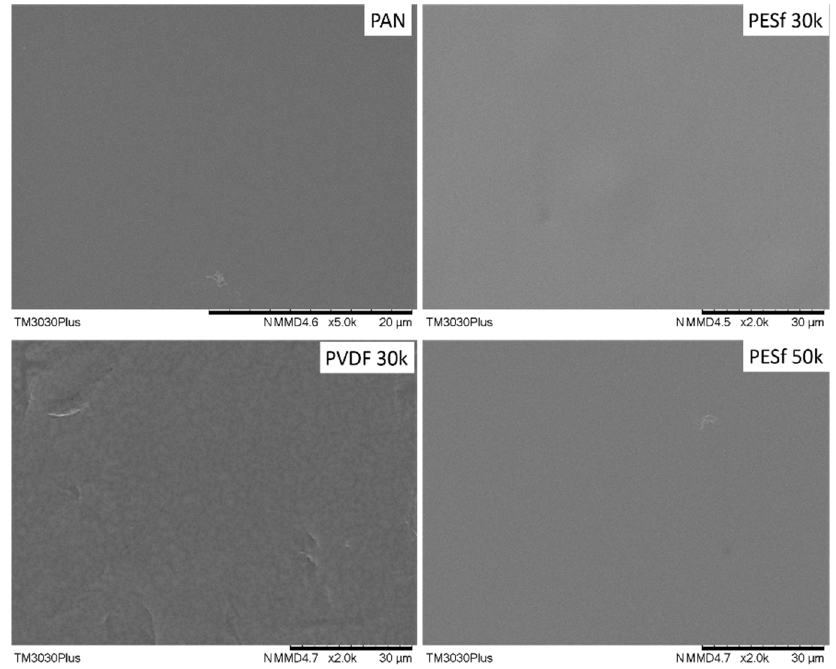
Figure 3. Surface morphology of the PAN, PESF 30k, PVDF 30k, and PESF 50k porous supports after being washed with tape water and DI water.